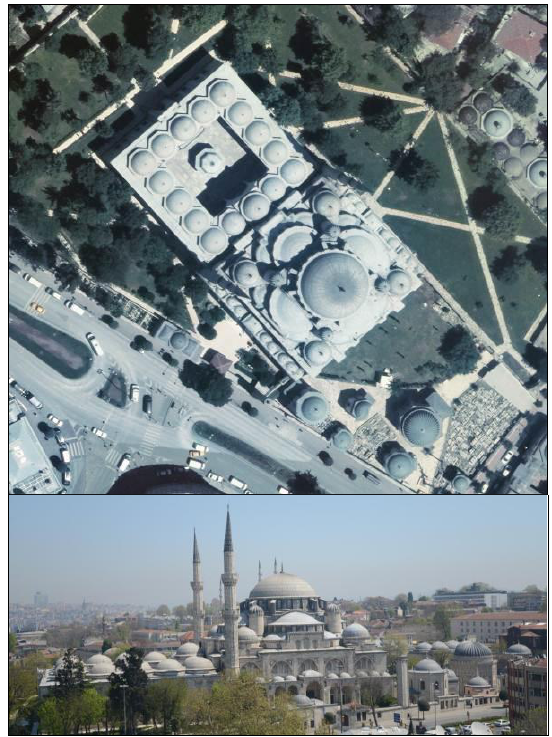
Figure 1. Şehzade Mosque in aerial imagery on top and SW direction façade